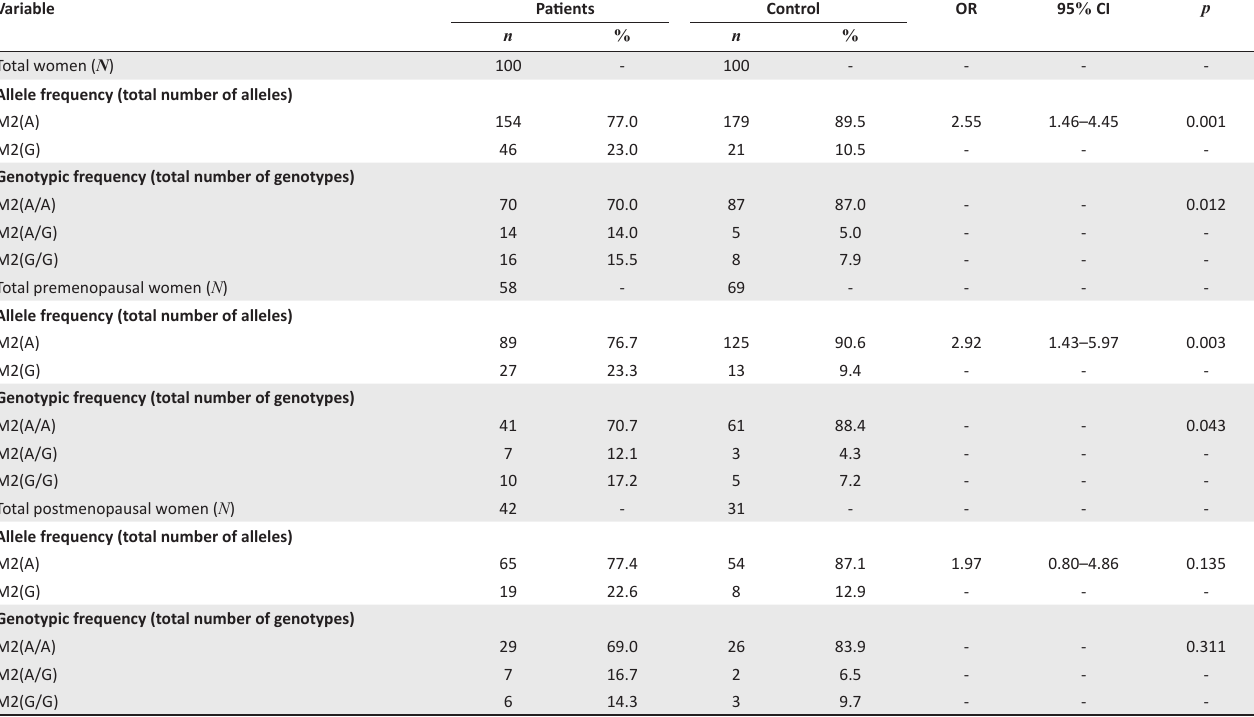
OR, odds ratio; CI, confidence interval.